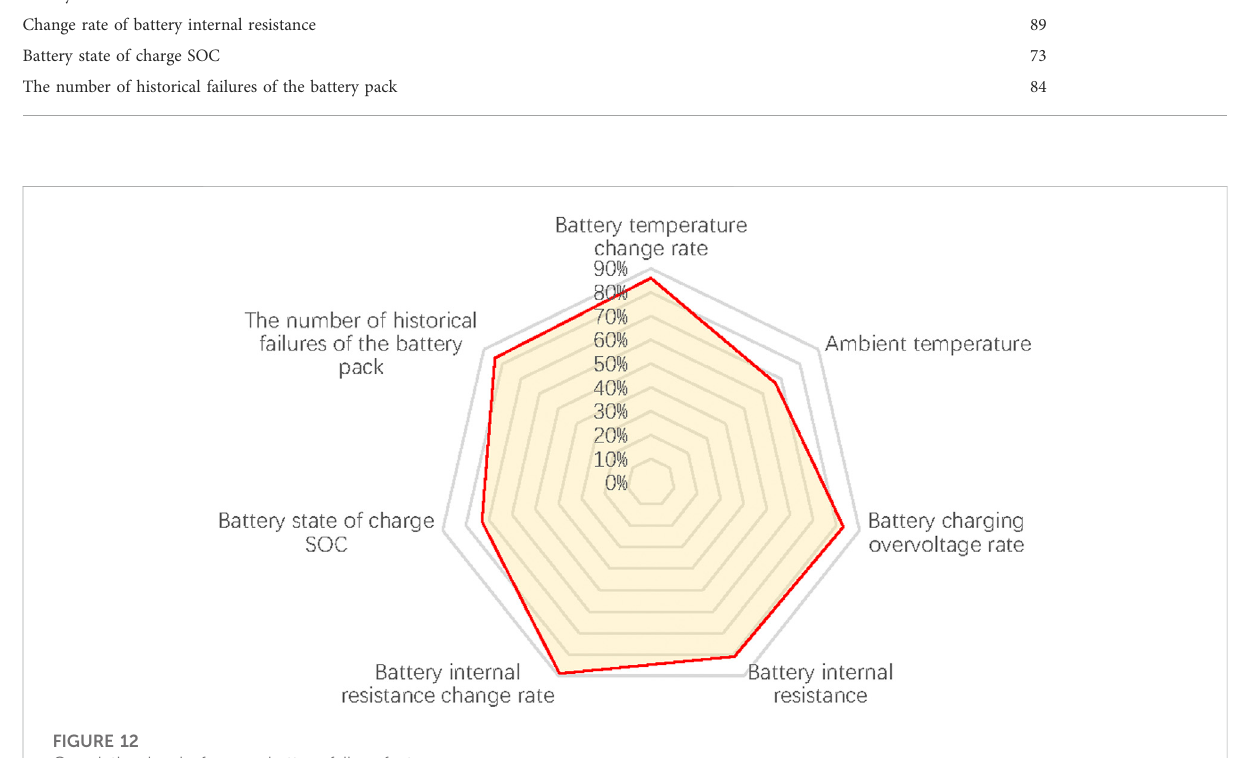
FIGURE 12 Correlation level of power battery failure